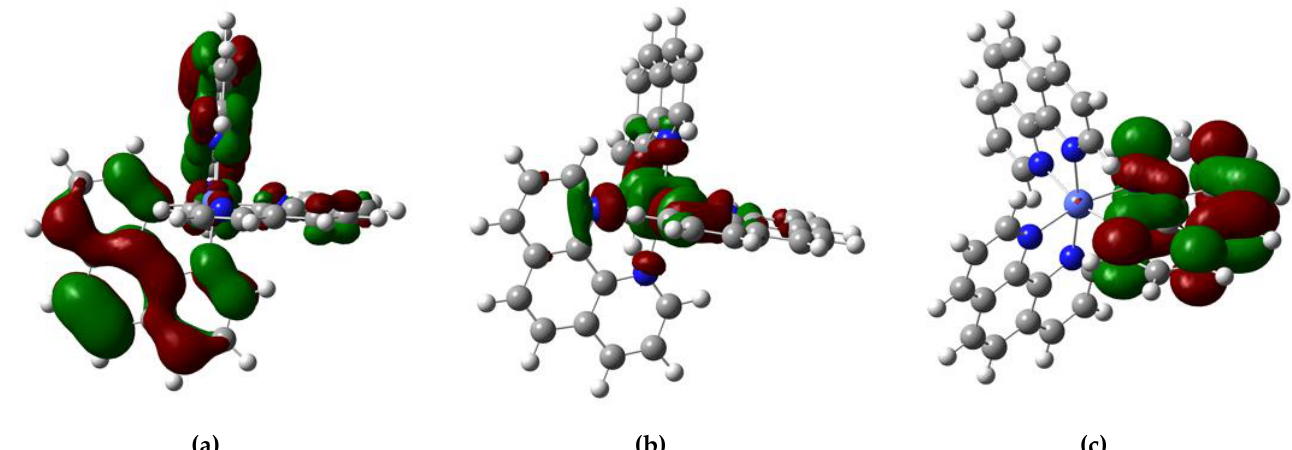
Figure 14. SOMO diagrams of the species ( a ) [Co II (phen) 3 ] 2+ , ( b ) [Co I (phen) 3 ] + , and ( c ) [Co I (phen)(phen − ) 2 ] − .